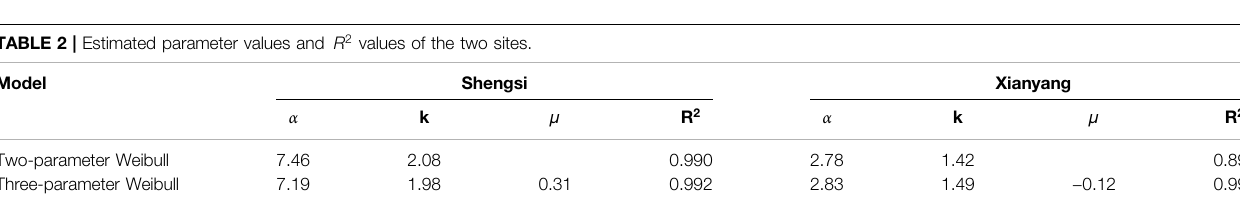
fi tting effect on the wind speed data of Shengsi, but the fi tting that of the two-parameter Weibull distribution in Xianyang.